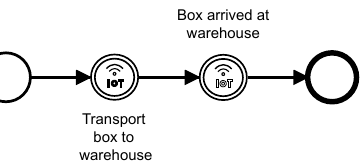
Figure 11. Usage of IoT intermediate catch and throw